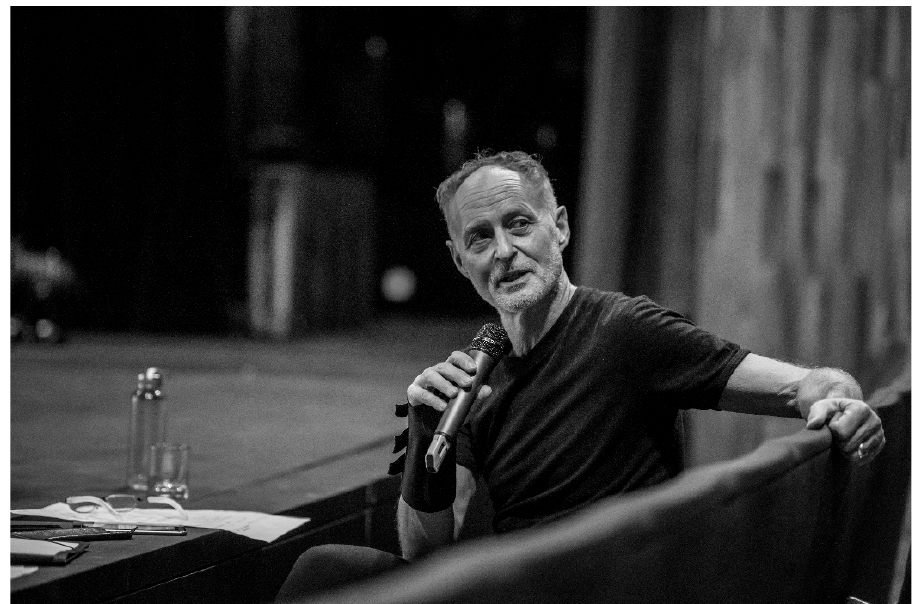
Figure 1. Pál Frenák—© Katalin Bobál, bobal photography.